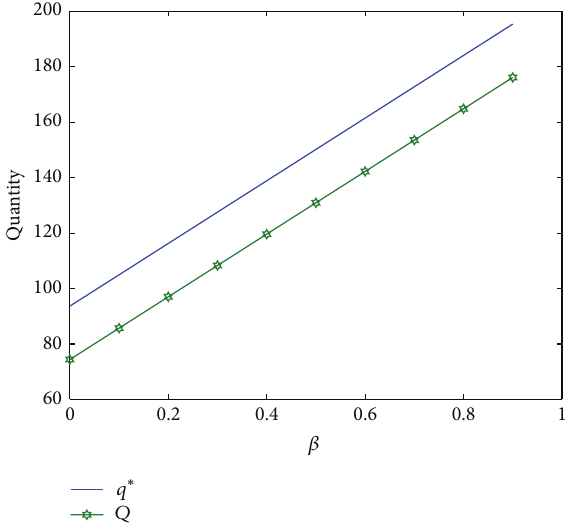
Figure12:Impactof 𝛽 onorderingquantityunderdemandcertainty and